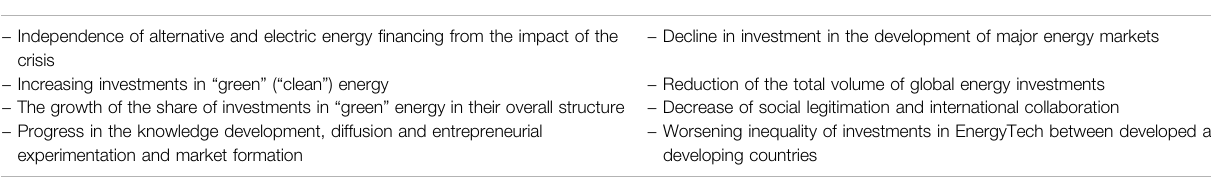
TABLE 1 | SWOT analysis of EnergyTech fi nancing problems during the COVID-19 crisis and in the post-pandemic period. Positive Trends in EnergyTech Financing in the Context of the COVID-19(S)